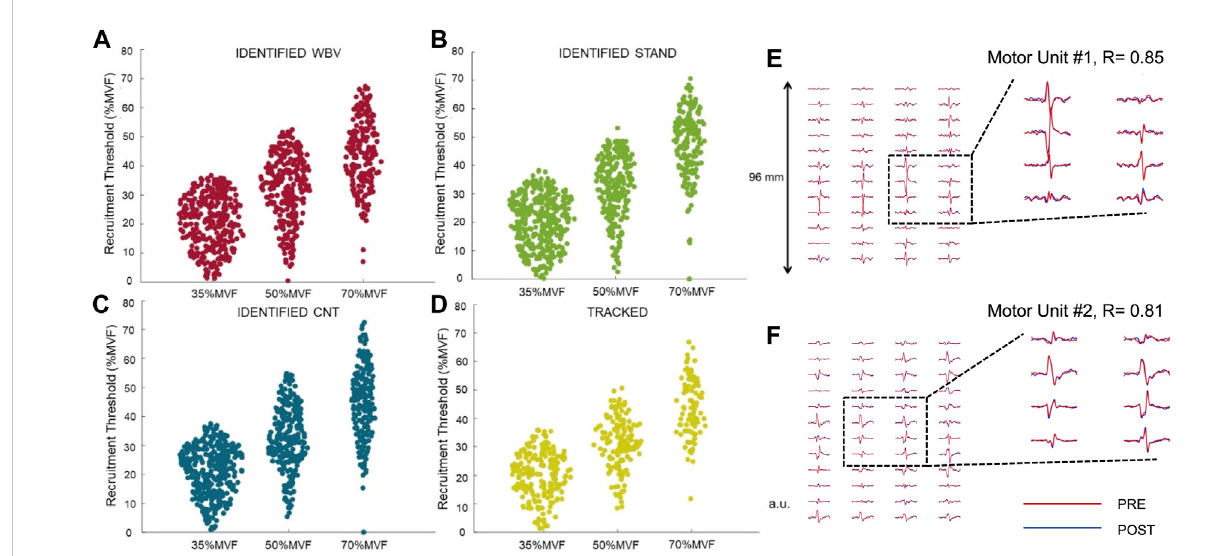
FIGURE 4 Motor unit tracking analysis. The present fi gure represents the total identi fi ed motor units in WBV (A) , STAND (B) , and CNT (C) classi fi ed on the recruitment threshold. Plot (D) displays the total number of motor units tracked across conditions classi fi ed on the recruitment threshold of the pre- condition. Plot (E,F) represent the tracking procedure of two different motor units; the action potential waveforms of the pre-and post-condition, obtainedfrombipolarhigh-densityEMGsignals,werecorrelatedinthisprocedure.Theredandthebluelinesarealmostoverlapped,asasignofhigh two-dimensional correlation (r). The columns and rows represent the dimensions of the high-density electrodes.